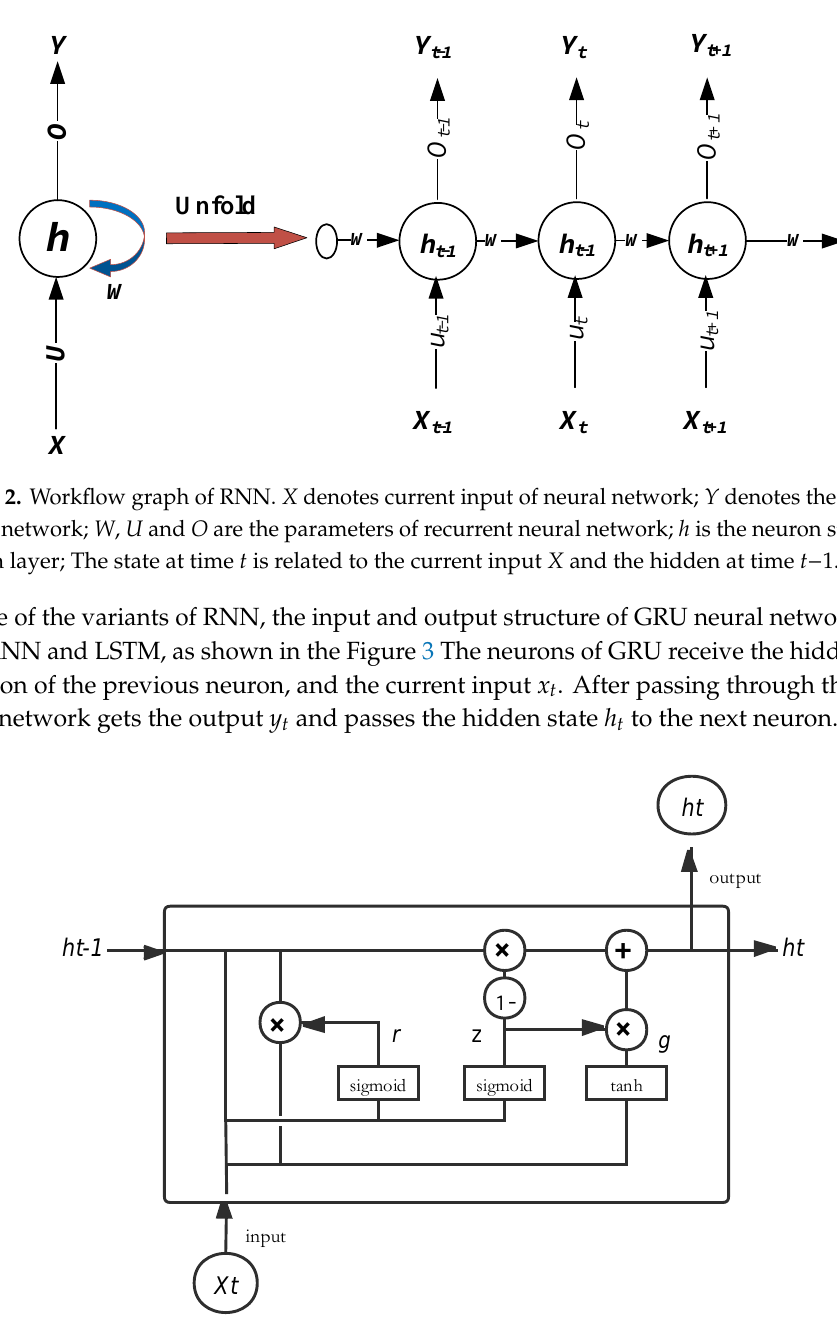
Figure 3. The internal structure of the GRU cell. r t —Reset gate. It allows the cell to forget certain parts of the state; z t —Update